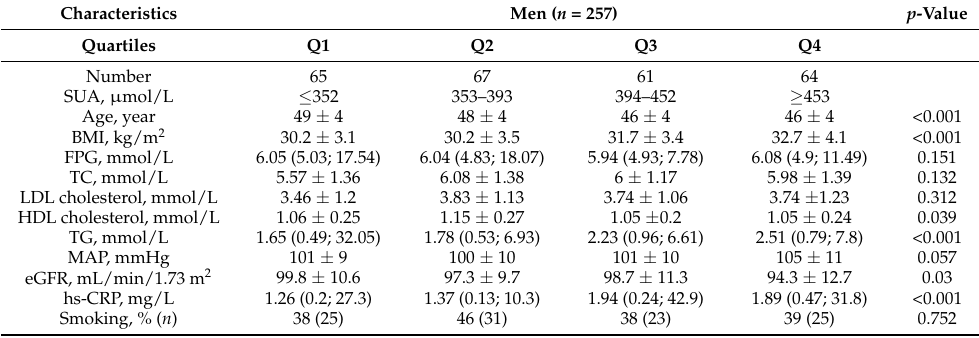
Table 4. The comparison of objective data according to uric acid quartile in men.